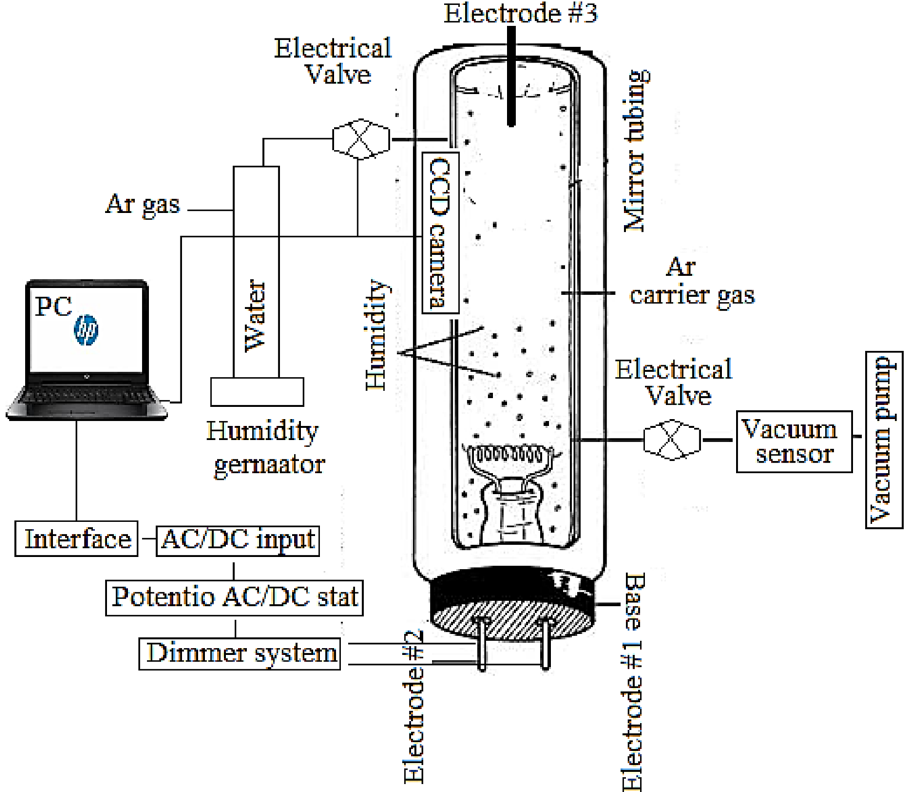
Figure 1. Schematic of the designed apparatus for humidity sensing